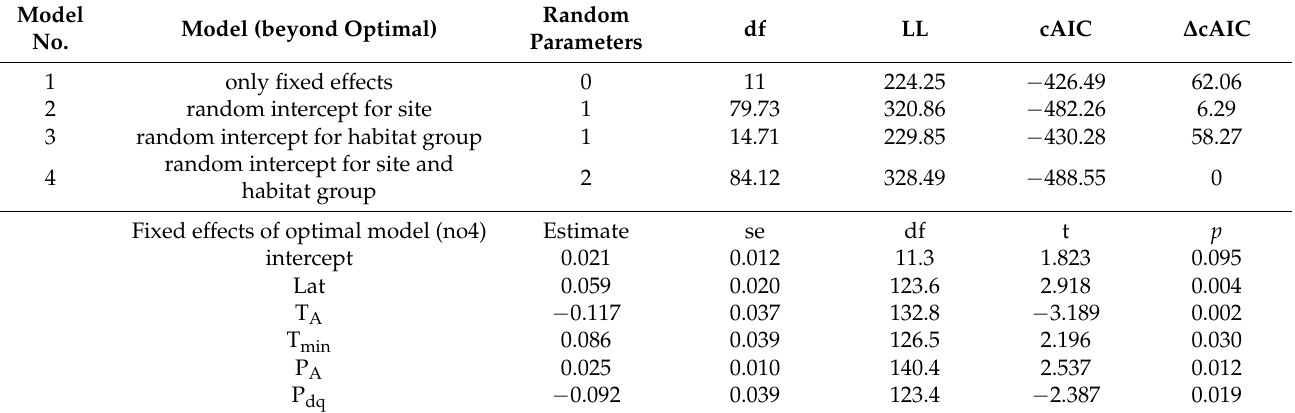
Table 3. Top: Results of the model selection procedure for the mixed-effects model of the difference in the invaded plot ratio between the two study periods (delta), showing model structure, the number of random parameters, degrees of freedom (df), log-likelihood (LL), conditional AIC (cAIC) and the difference in cAIC between the various random component models. Bottom: Parameter estimates of the fixed effects of the optimal random structure model (no. 4).